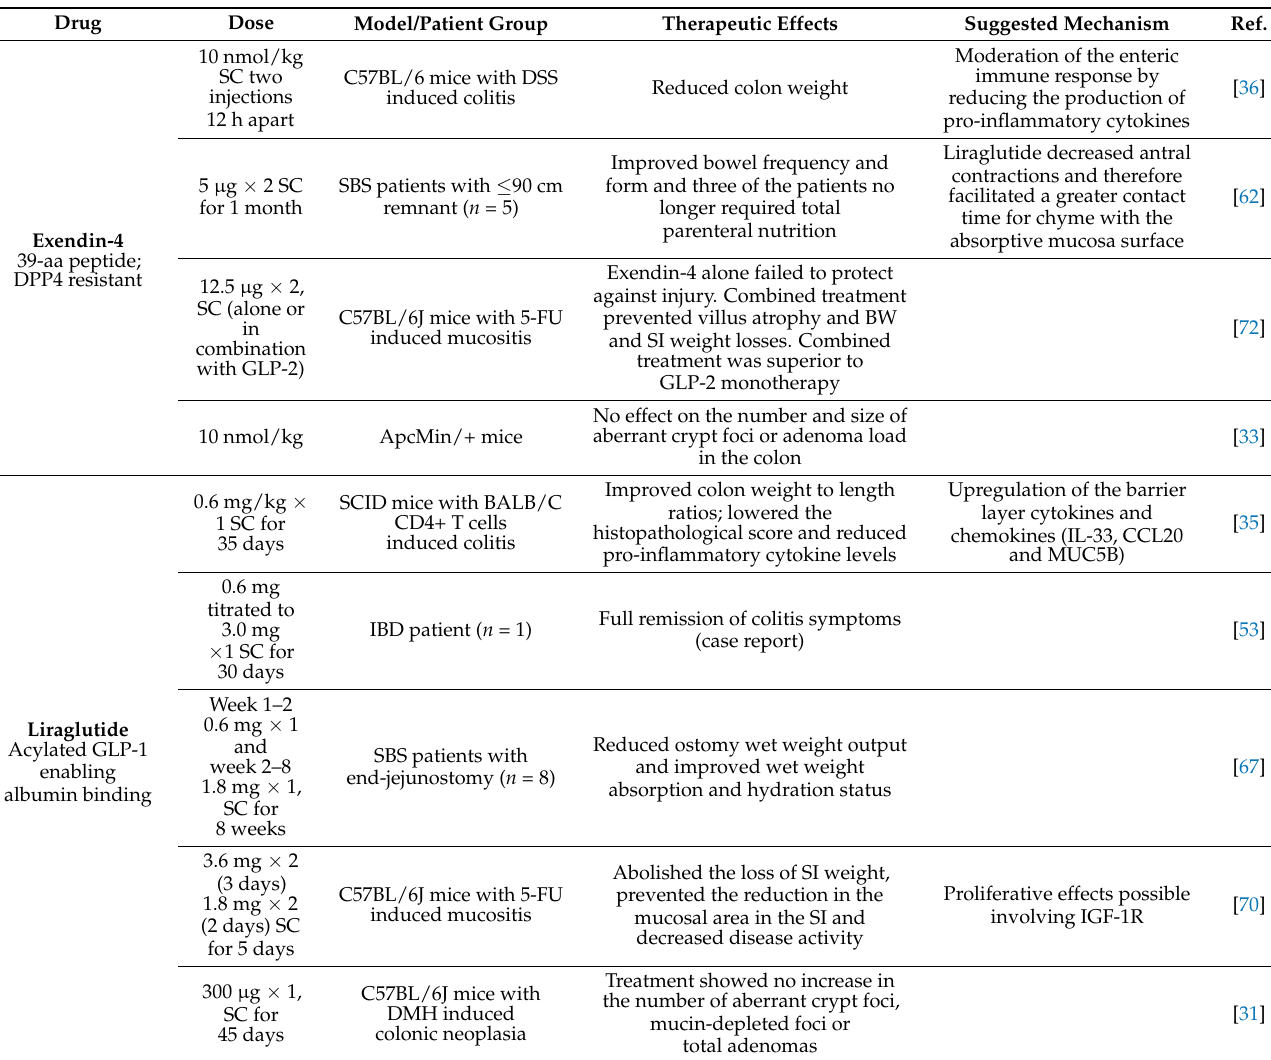
Table 1. Summary of the reviewed studies where GLP-1 or GLP-1 mimetics are used as treatment for intestinal disease. Drug Dose Model/Patient Group Therapeutic Effects Suggested Mechanism